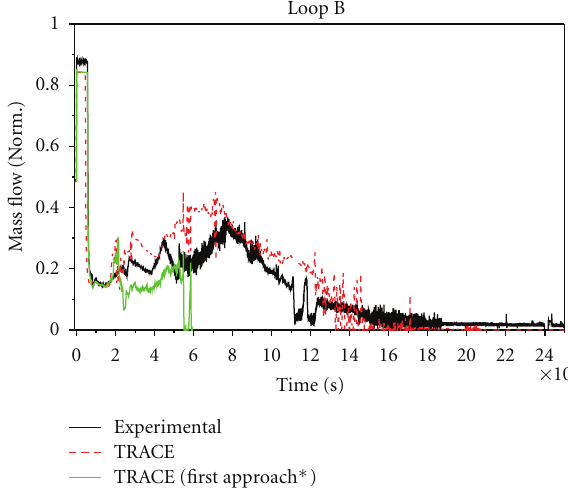
Figure 11: Mass flow in loop B using both nodalizations of the SG’s primary and secondary